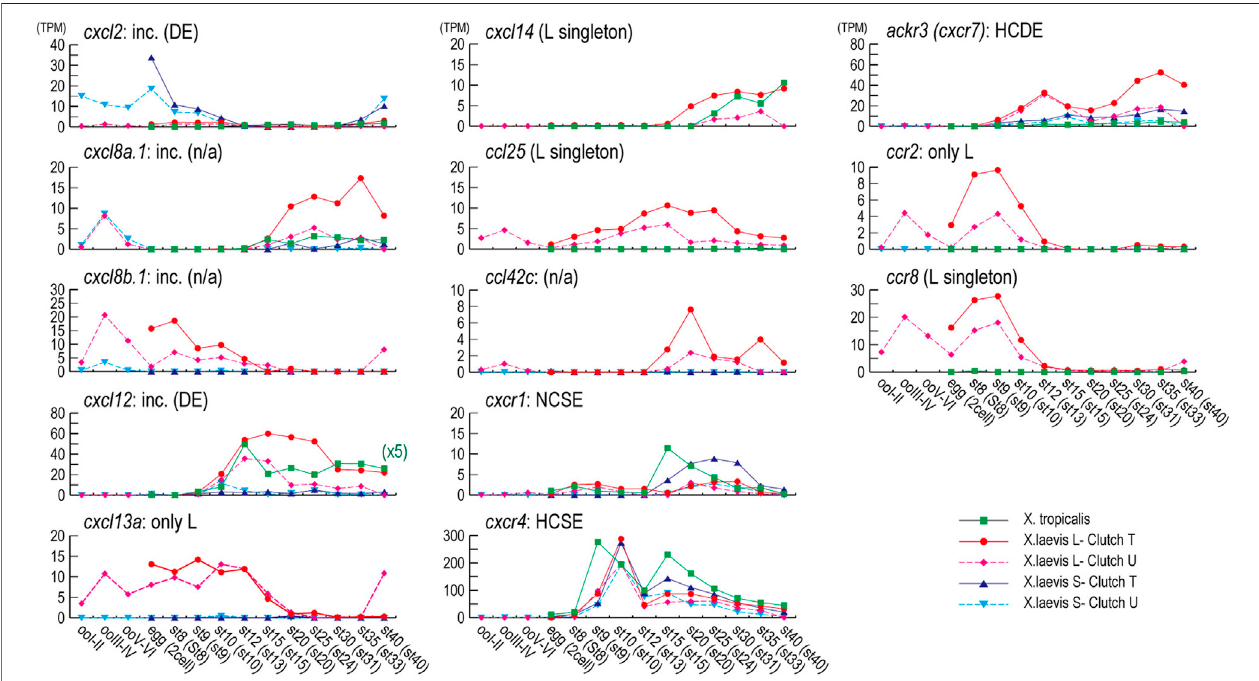
FIGURE 5 | Expression pro fi les during oogenesis and embryogenesis. Genes with a max TMP value of 5 or higher during oogenesis and embryogenesis are presented. Expression pro fi les for X. tropicalis were obtained from Tan et al. (2013). Unfortunately, cxcl8 , cxcl13a , and ccl42c have no expression pro fi le of X. tropicalis . The vertical axis shows the expression level (TPM), and the horizontal axis is the developmental stages of X. laevis , X. tropicalis indicated within parentheses. All TPM values are shown in Supplementary Table S1 . Orthologous family names and results of transcriptome correlation analysis are indicated on the upper left of each graph. Symbols . Square: X. tropicalis (green); circle,: X. laevis L-clutch T (red); diamond: X. laevis L-clutch U (magenta); triangle: X. laevis S-clutch T (blue); reverse triangle: X. laevis S-clutch U (cyan). Note that the TPM value of X. tropicalis in cxcl12 was indicated one- fi fth scale to increase the resolution